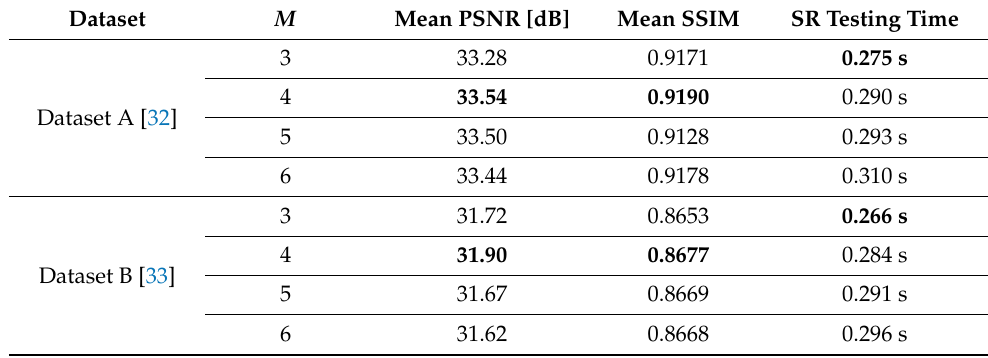
Table 4. Quantitative Analysis of the Proposed SR Model by Varying the Value of M . Bold numbers represent the highest value of SSIM and